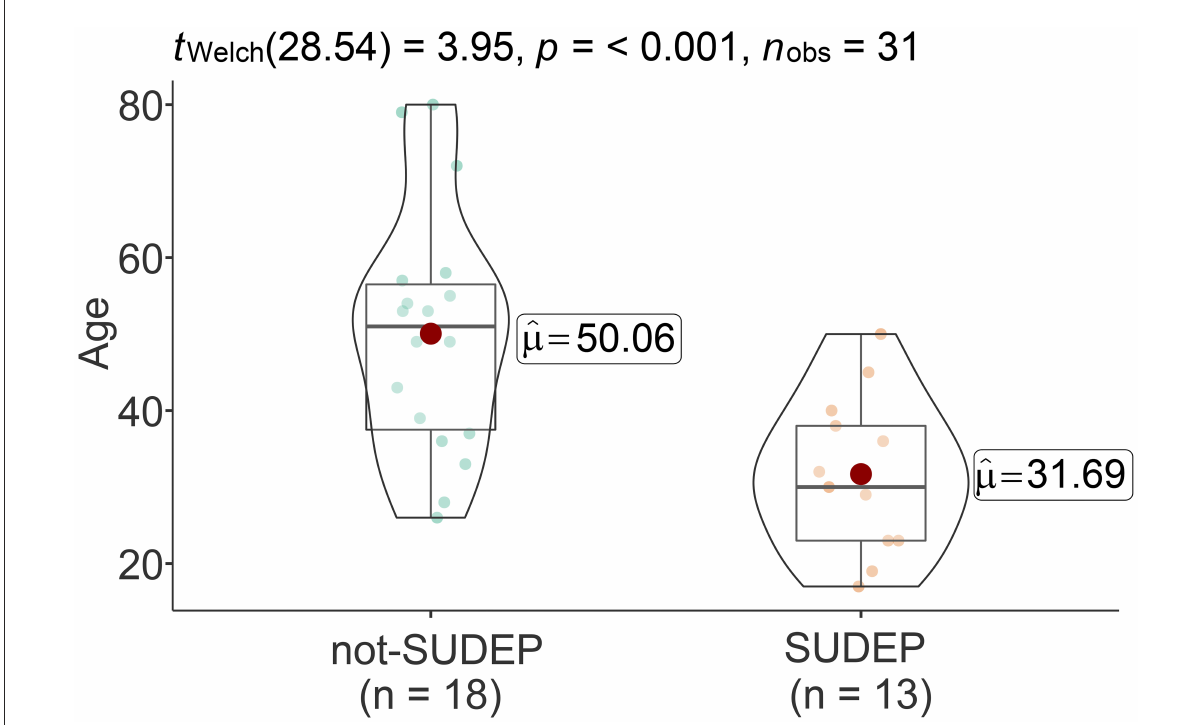
FIGURE2 Age comparison between SUDEP and not-SUDEP groups (red dot represents mean value).